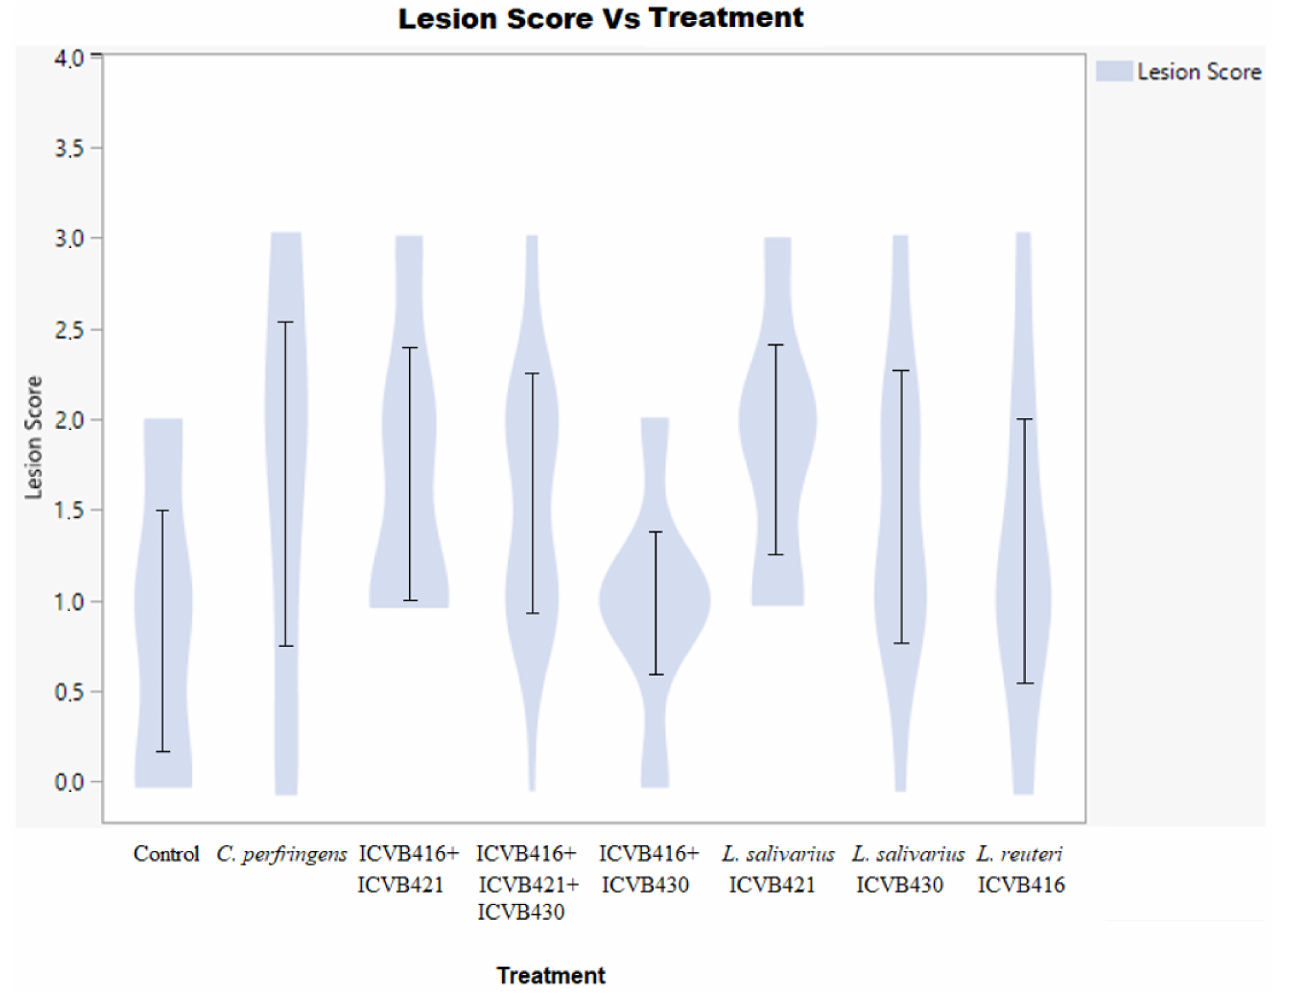
Figure 5. Lesion score layout. It shows the distribution of lesions depending on the treatment. It shows proportionally the number of animals that presented each type of lesion score depending on the